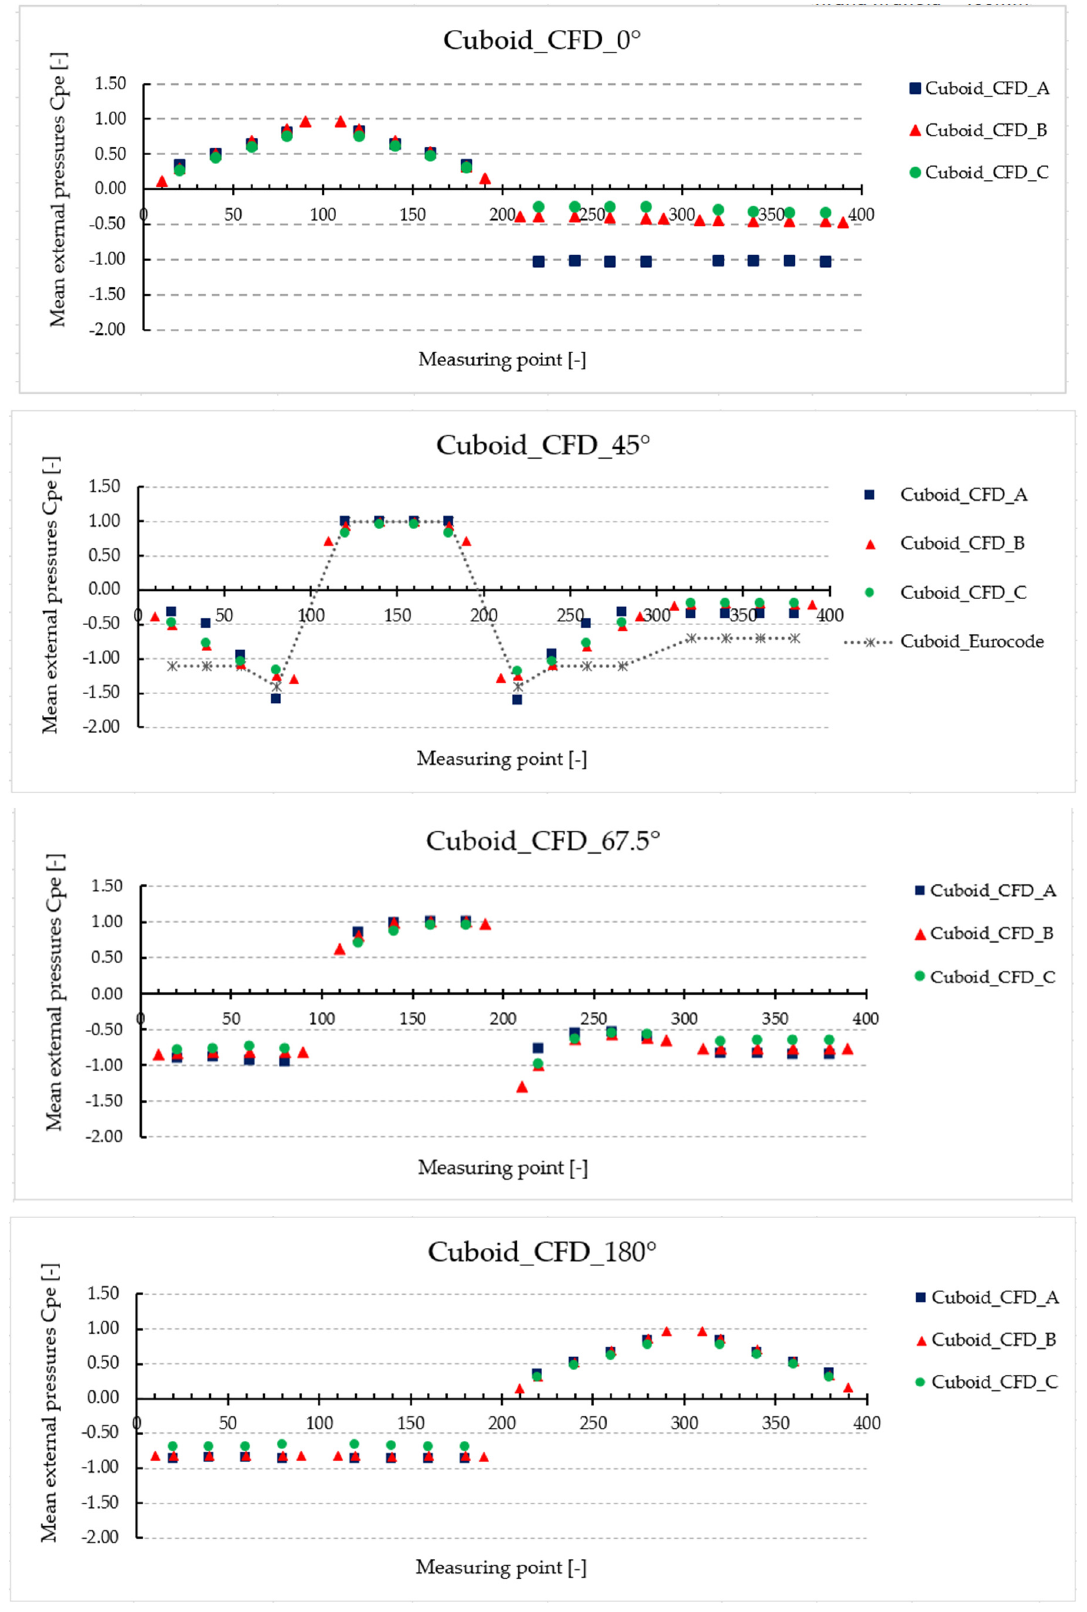
Figure 14. The CFD simulation of the cuboid—the mean values of c pe calculated for different wind directions (in the case of 45°, the values were compared with c pe, 1 specified in [25]).